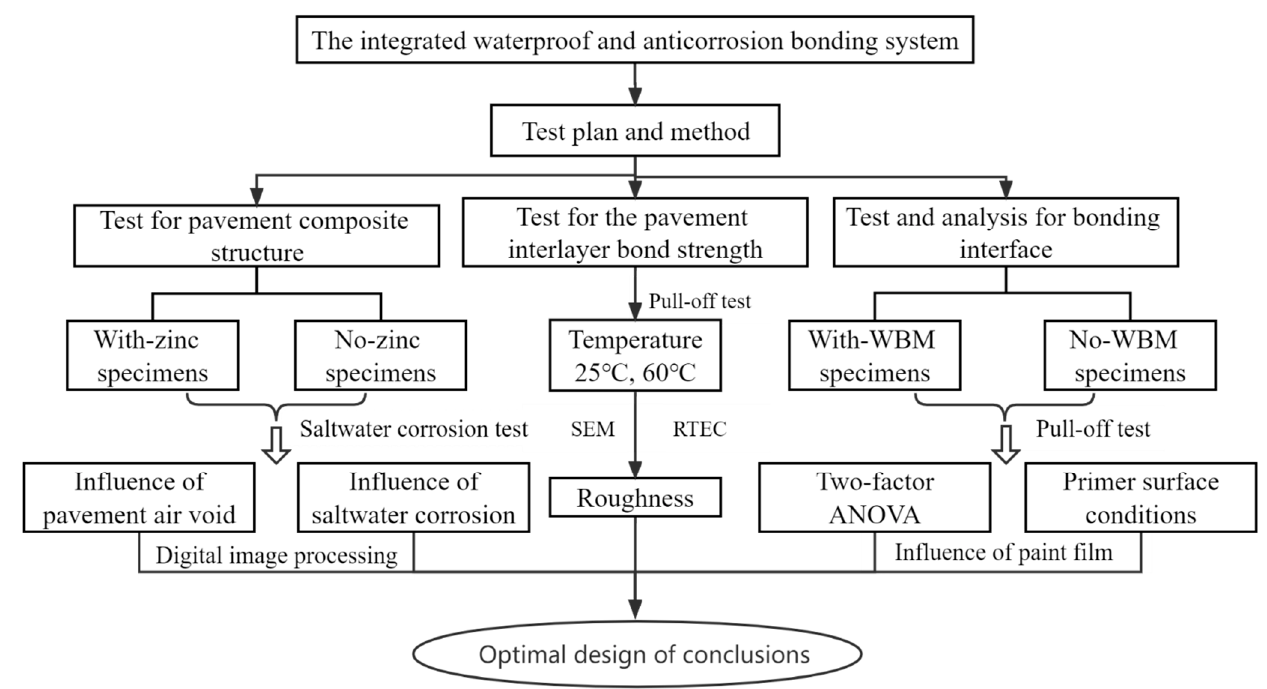
Figure 4. The flowchart of the research approach.